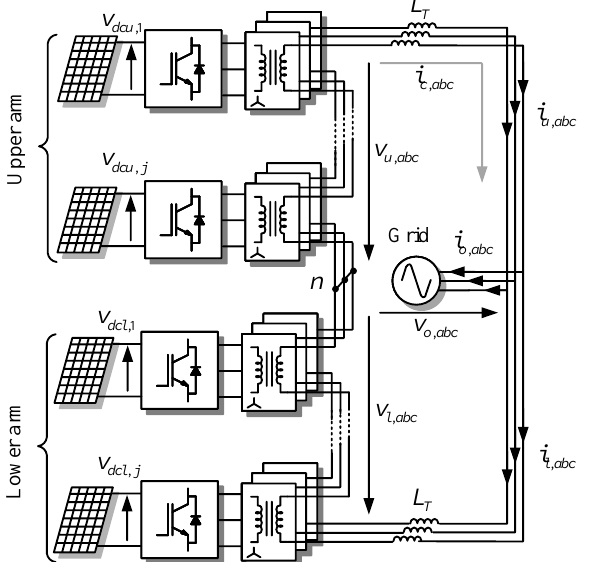
Figure 1. Three-phase isolated multi-modular converter (IMMC).